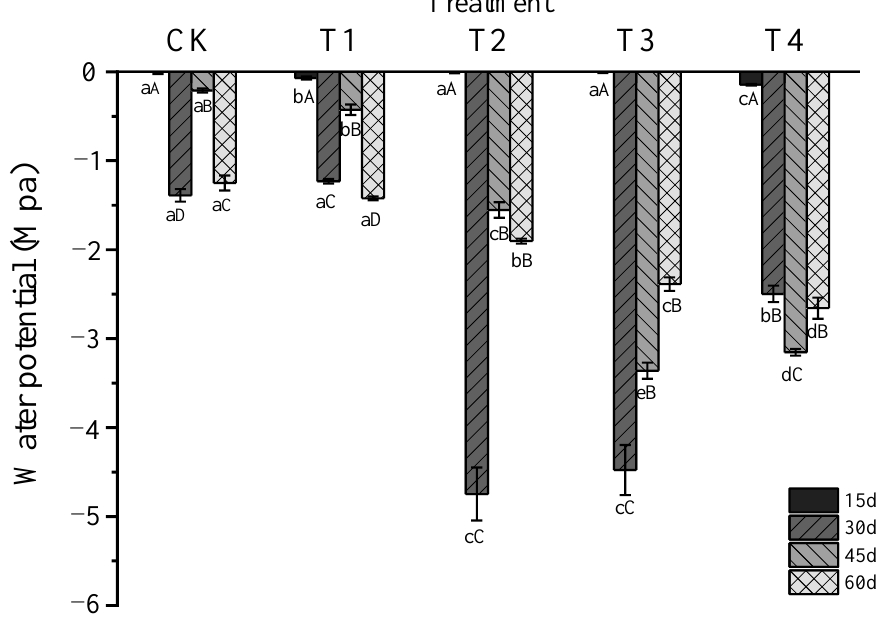
Figure 3. Changes of water potential in leaves of Glycyrrhiza uralensis under different water stress treatments. Different lowercase letters indicate a significant difference among treatments at a 5% level. Different capital letters indicate a significant difference at a 5% level between different times.